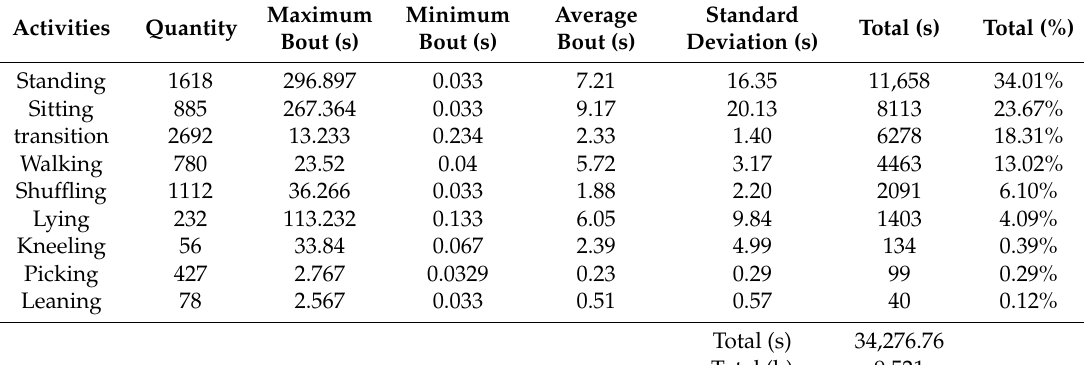
Table 7. Summary of the in-lab activities, excluding Undefined, Static, Dynamic, Shake and